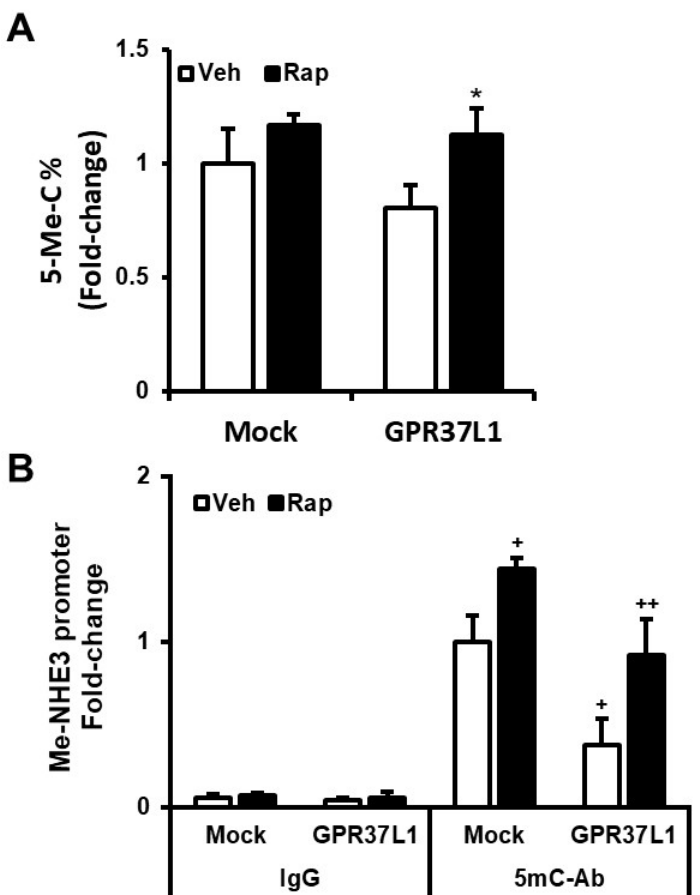
Figure 10. GPR37L1 inhibits genomic DNA methylation. ( A ) Genomic DNA prepared form hRPTCs expressing GPR37L1-GFP were analyzed for 5-cytosine methylation using EZ DNA Methylation-Gold Kit (Zymo Research, Irvine, CA, USA). n = 3/group, * p < 0.05 vs. GPR37L1/Veh, t-test. ( B ) Methylation status of NHE3 promoter region was determined by methylated DNA immunoprecipitation followed by quantitative PCR. n = 3/group, + p < 0.05 vs. 5mC-Ab/Mock/Veh, t -test. ++ p < 0.05 vs. 5mC-Ab/GPR37L1/Veh, t -test.